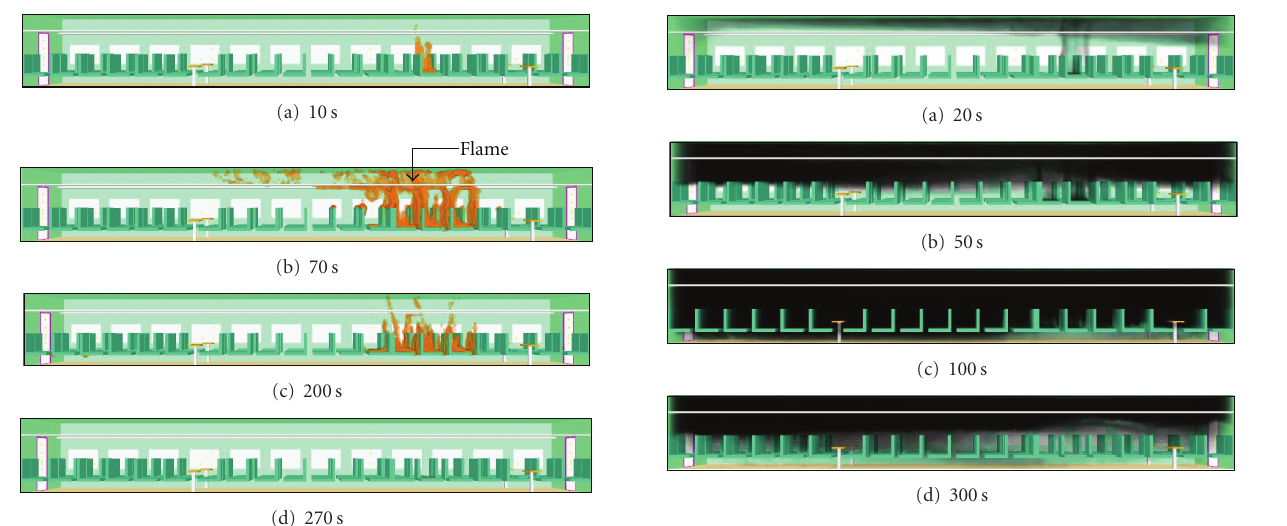
Figure 6: Flame spread inside the train compartment.